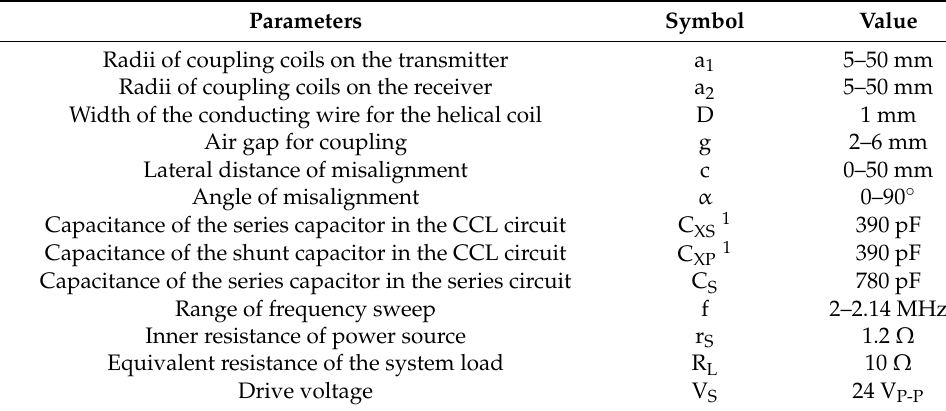
Figure 5. Process chart of the simulation for WPT system topology performance. Table 1. List of parameters used in the simulations in this